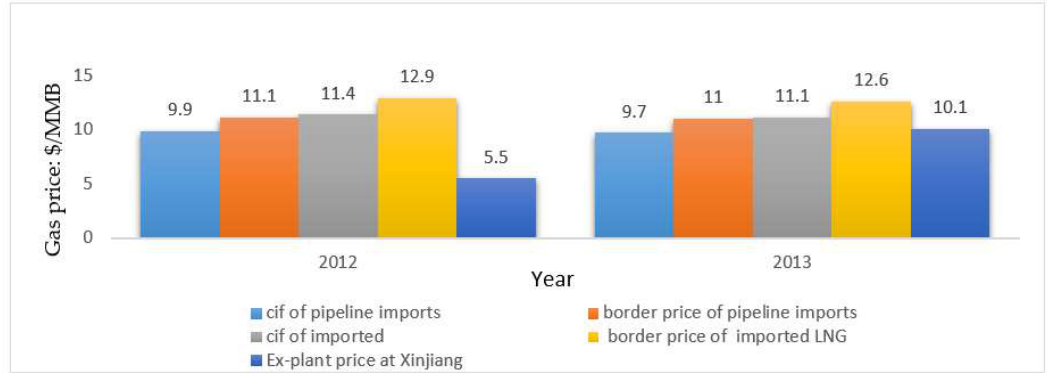
Figure 15. Border price vs. ex-plant price in 2012 and 2013. Data Source: import LNG & pipeline gas prices (CNPC, 2014), ex-plant prices at Xinjiang (authors’ estimates based on NDRC, 2013; NDRC, 2014).